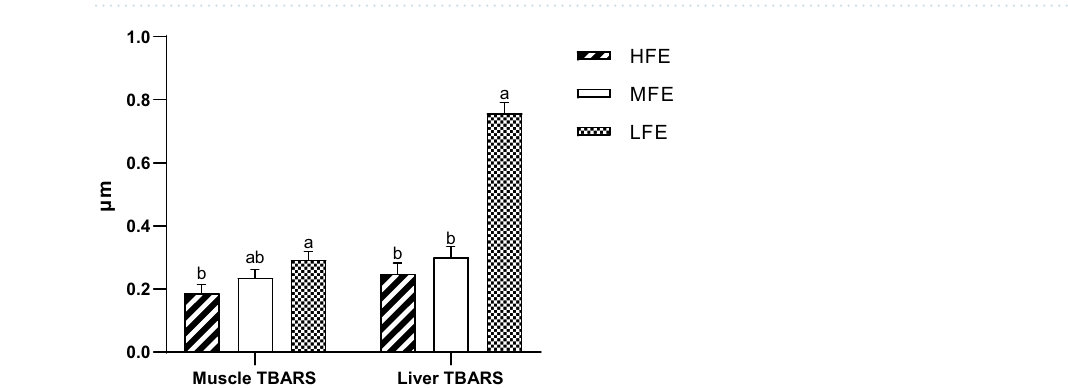
Figure 3. Correlations ( r ) of liver fat with ( a ) liver dry matter and ( b ) liver TBARS value of individually housed hens aged 45 weeks ranked based on differences in feed efficiency (n = 30; 10 per FE group). HFE, high feed efficiency; MFE, medium feed efficiency; LFE, low feed efficiency; r = coefficient of correlation, p = level of significance.